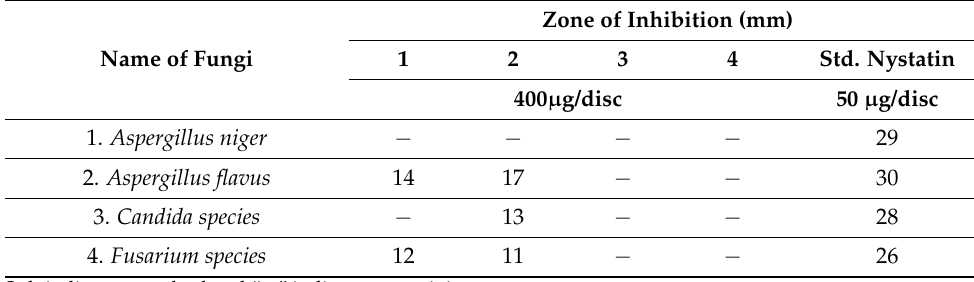
Table 2. Antifungal activity of the compounds 1 – 4 and standard